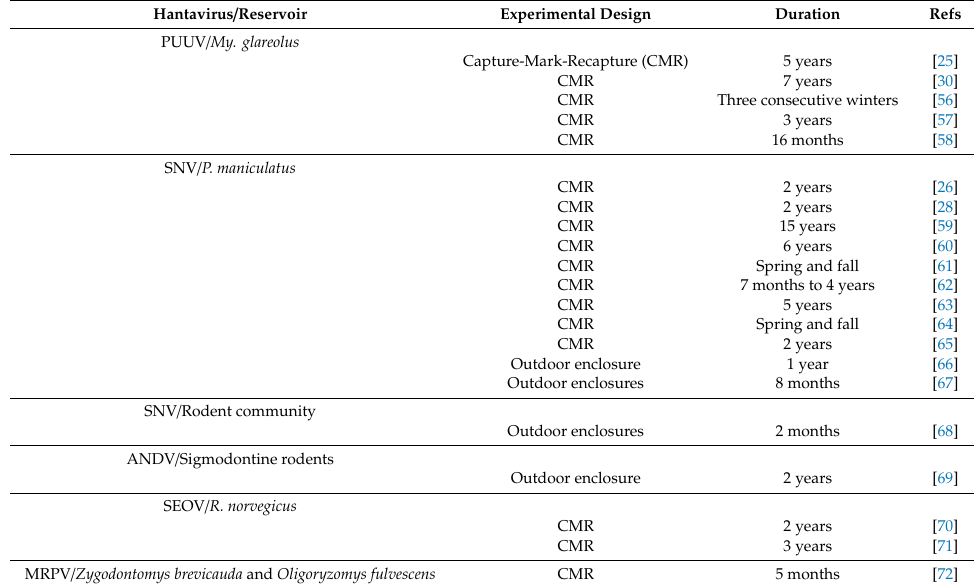
(b) Environmental